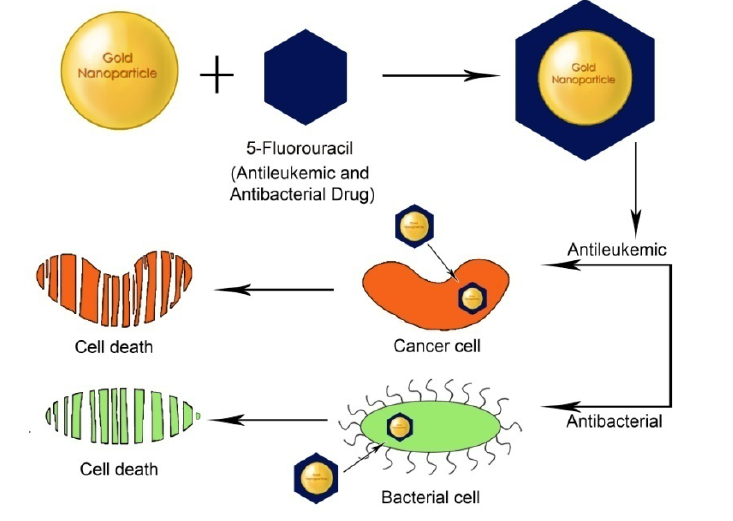
Figure 3. Functionalized GNPs (fGNPs) for drug delivery: Targeting specific cells with higher loading efficiency, targeted delivery and efficient release of